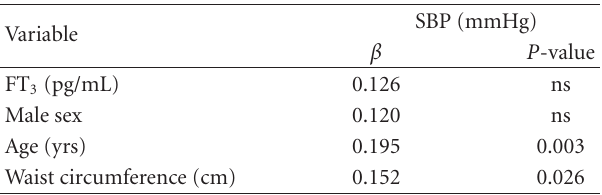
Table 4: Determinants of 24h systolic blood pressure (SBP) in the multiple linear regression model.